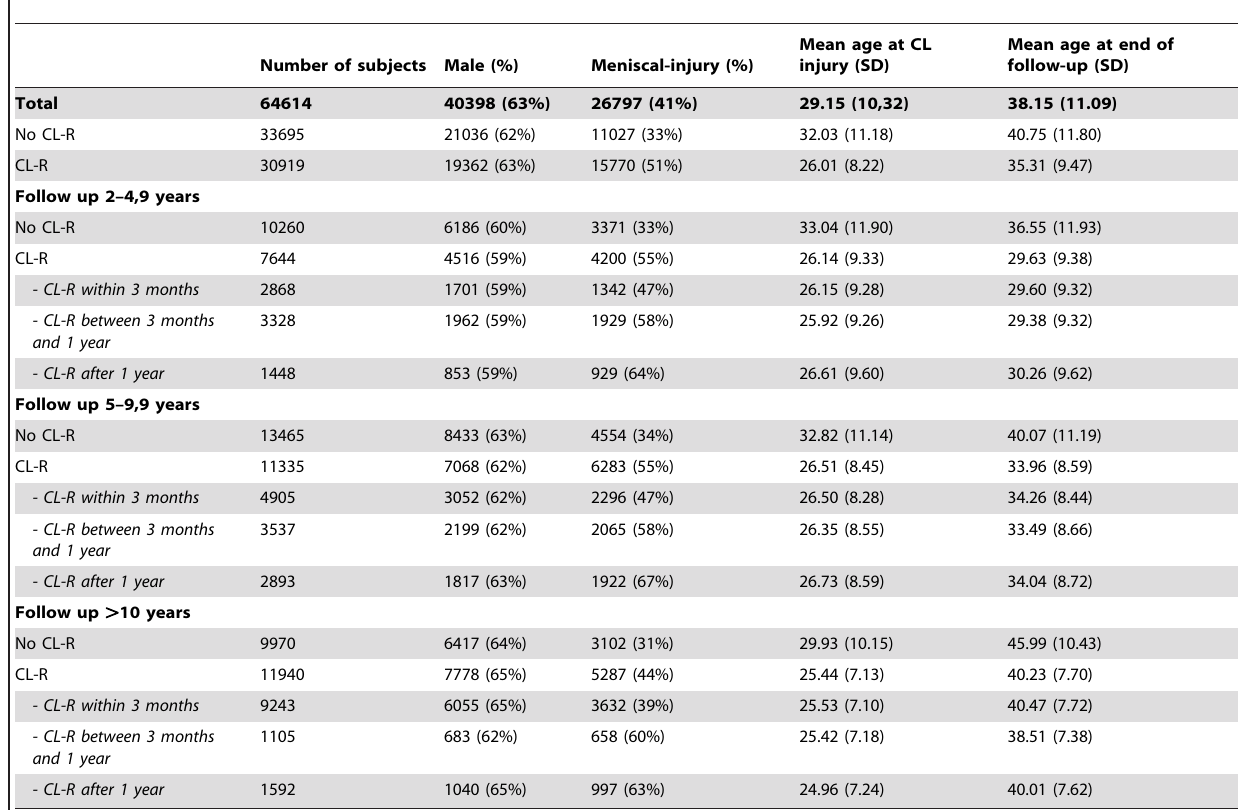
Table 1. Characteristics of the study population according to type of treatment and follow-up time.